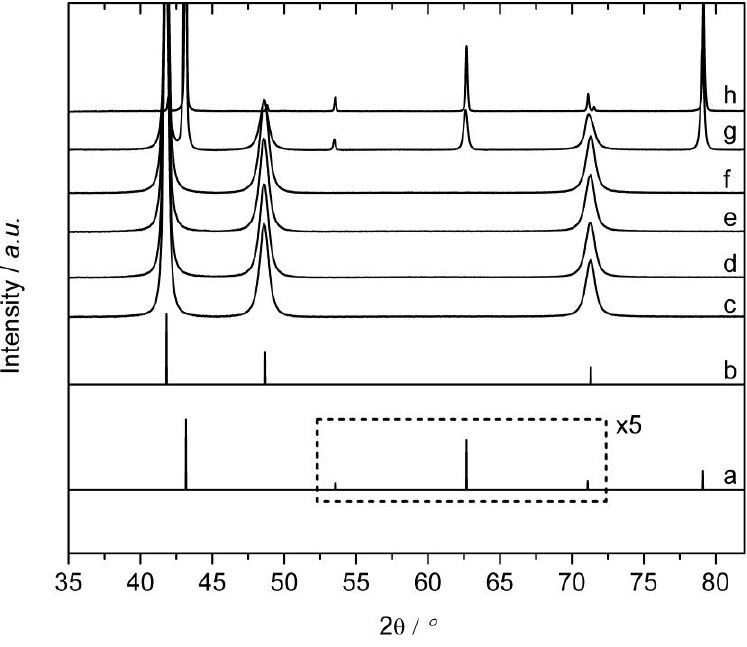
Figure 3. Calculated X-ray diffraction patterns of ( a ) ordered Cu ( b ) disordered Cu Pd ( a = 3.739 Å); ( c – h ) show the disorder-order transition for a 60 40 disordered Cu Pd sample annealed at 200 °C for ( c ) 2 h; ( d ) 4 h; ( e ) 8 h; ( f ) 16 h; 60 40 ( g ) 32 h; and ( h ) 114